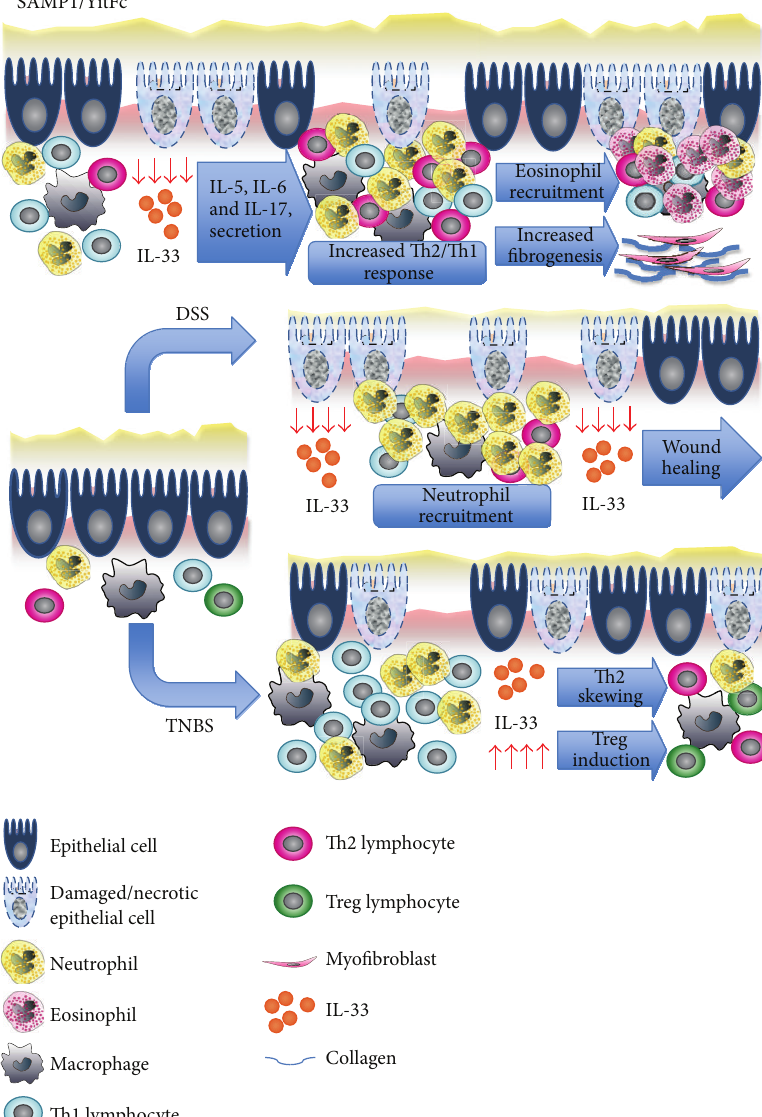
Figure 2: Role of IL-33 in murine models of intestinal inflammation. Experimental results obtained from SAMP mice that develop spontaneous Th1/Th2-driven enteritis suggest a pathogenic role for IL-33 at the onset of intestinal inflammation in this specific model. In fact, epithelial-derived IL-33 promotes the release of proinflammatory cytokines from LP immune cells, enhancing both Th1 and Th2 responses. Moreover, IL-33 induces the production of eotaxin-1 and eotaxin-2, which leads to eosinophil chemotaxis to the inflamed gut. In addition, IL-33 activates the expression of profibrotic genes, contributing to the development of intestinal fibrosis (upper panel). Different results are observed in chemically induced models of intestinal inflammation (middle and lower panels). During the onset of acute DSS-induced colitis, IL-33, likely released by necrotic/damaged epithelial cells, participates in the development of intestinal inflammation with a potent chemotactic effect on neutrophils, cells that play a pivotal role in this specific model of colitis (middle panel). Conversely, during the recovery phase of chronic DSS colitis, IL-33 appears to promote wound healing, inducing the restoration of epithelial barrier integrity. On the contrary, when IL-33 is administered to mice displaying a TNBS-induced colitis, which is mainly driven by a Th1 immune response, IL-33 shows an anti-inflammatory effect as a resultof theskewing towards a Th2 immunophenotype and thepotential induction of Tregulatory cell activation (lower